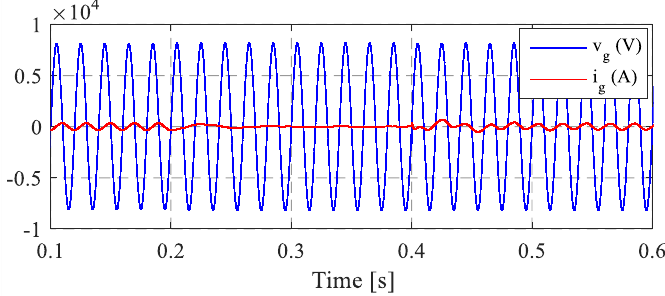
Figure 9. Grid voltage and current of phase-a before and after reactive power compensation.